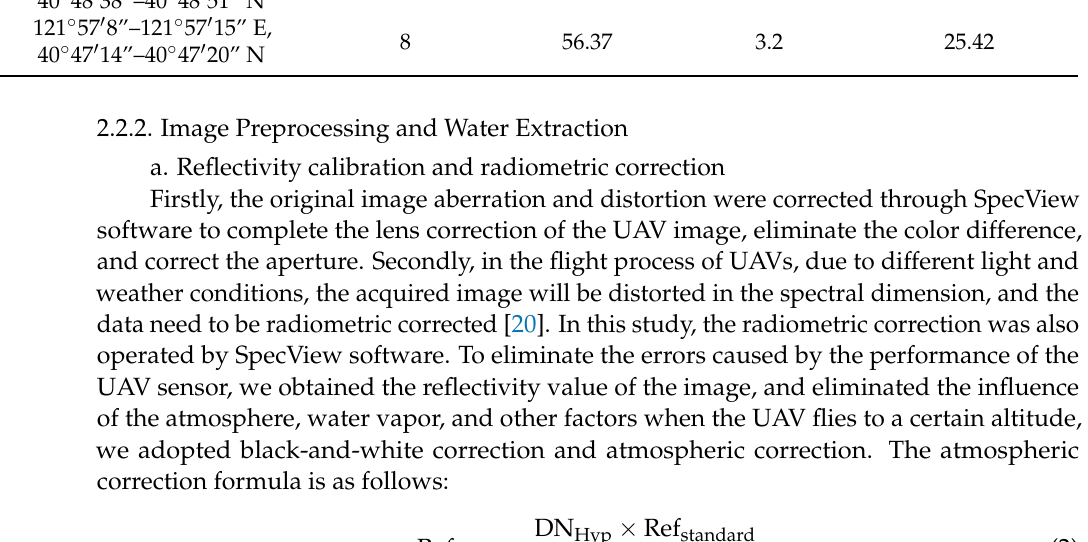
Table 1. Turbidity statistics of sampling points.